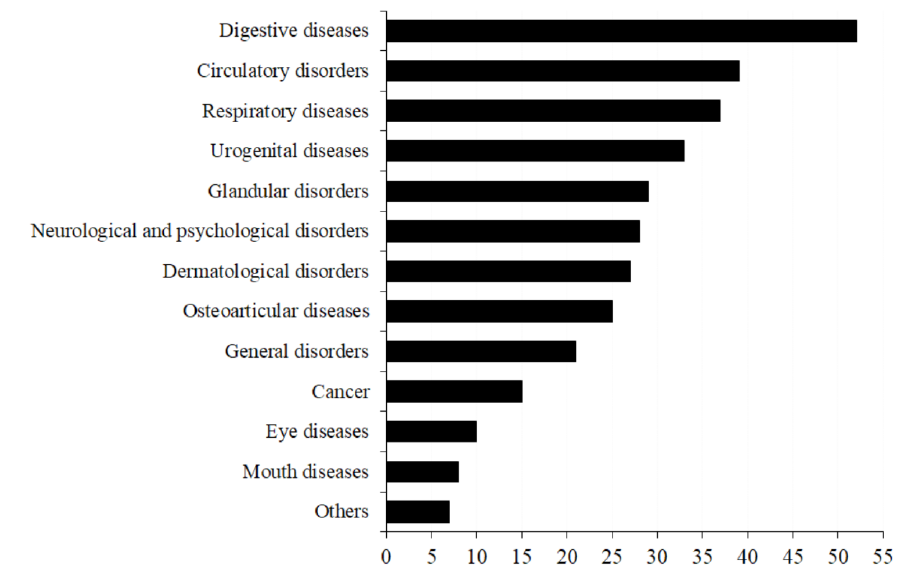
Figure 5. Number of used medicinal plant species in each ailment